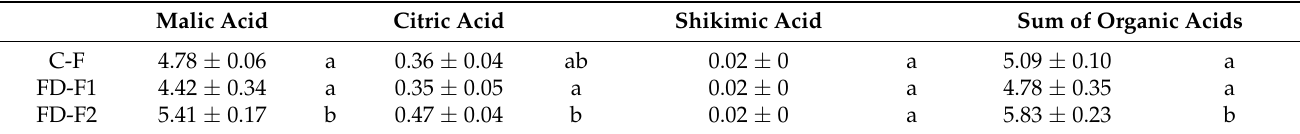
Table 2. The content of individual organic acids and the sum of organic acids: malic acid, citric acid, shikimic acid (mean ± SE in g kg − 1 fresh weight) in flesh of undamaged apples (C-F), and damaged apples: flesh underneath healthy peel (FD-F1) and flesh underneath corky peel (FD-F2). Different letters in the columns denote statistical differences between treatments (the Duncan test, p <